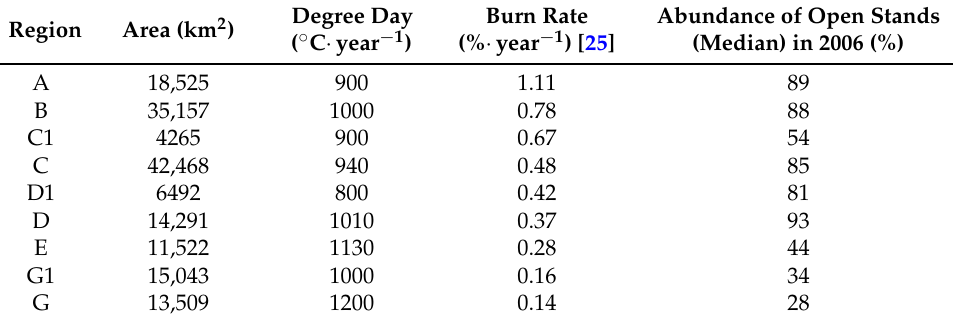
Figure 1. Burn rates [25] and degree-days [34] for the study area. The hatched area lies outside of the spruce-moss bioclimatic domain [9] or a regional burn rate could not be estimated [25]. The northern limit of commercial forests was set in 2002 by the Ministère des Ressources Naturelles et de la Faune [35]. Table 1. General information on the 10 fire zones of the study area.